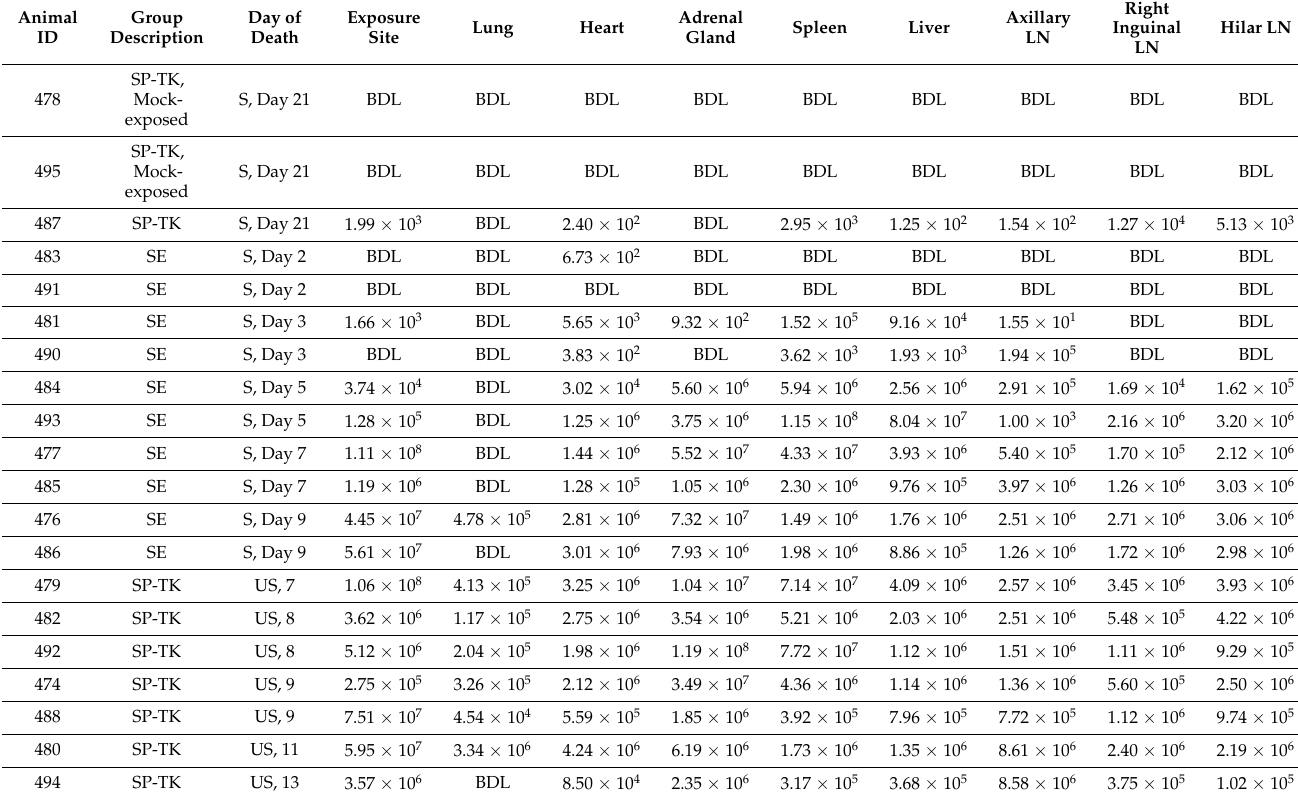
Table 6. Viral Load in Tissues as Determined by qRT-PCR Assay (GE/ µ g total